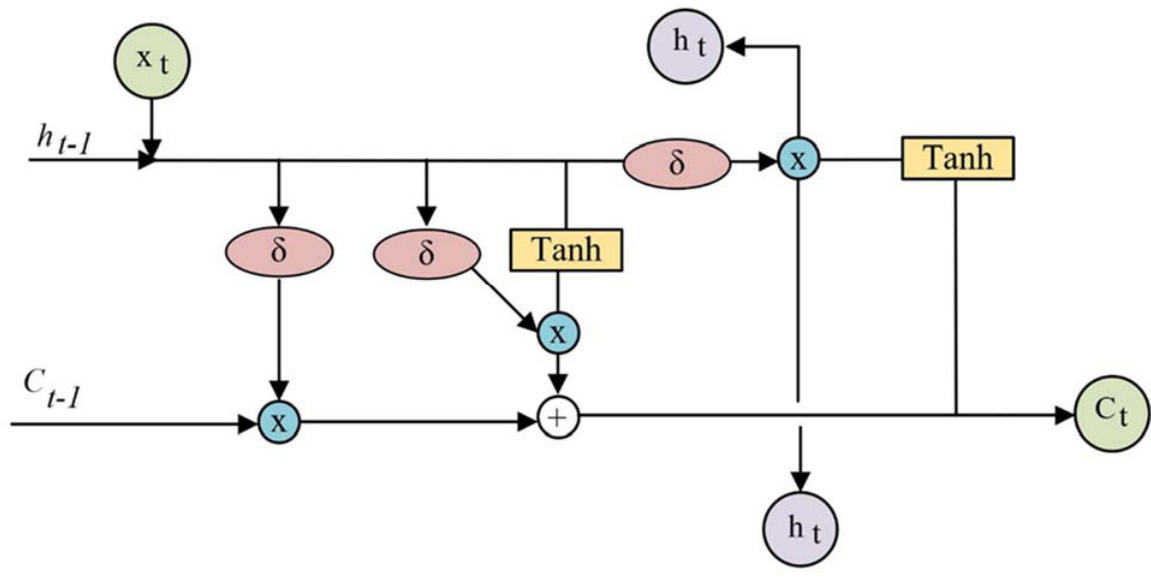
Figure 6. Recurrent neural network with LSTM